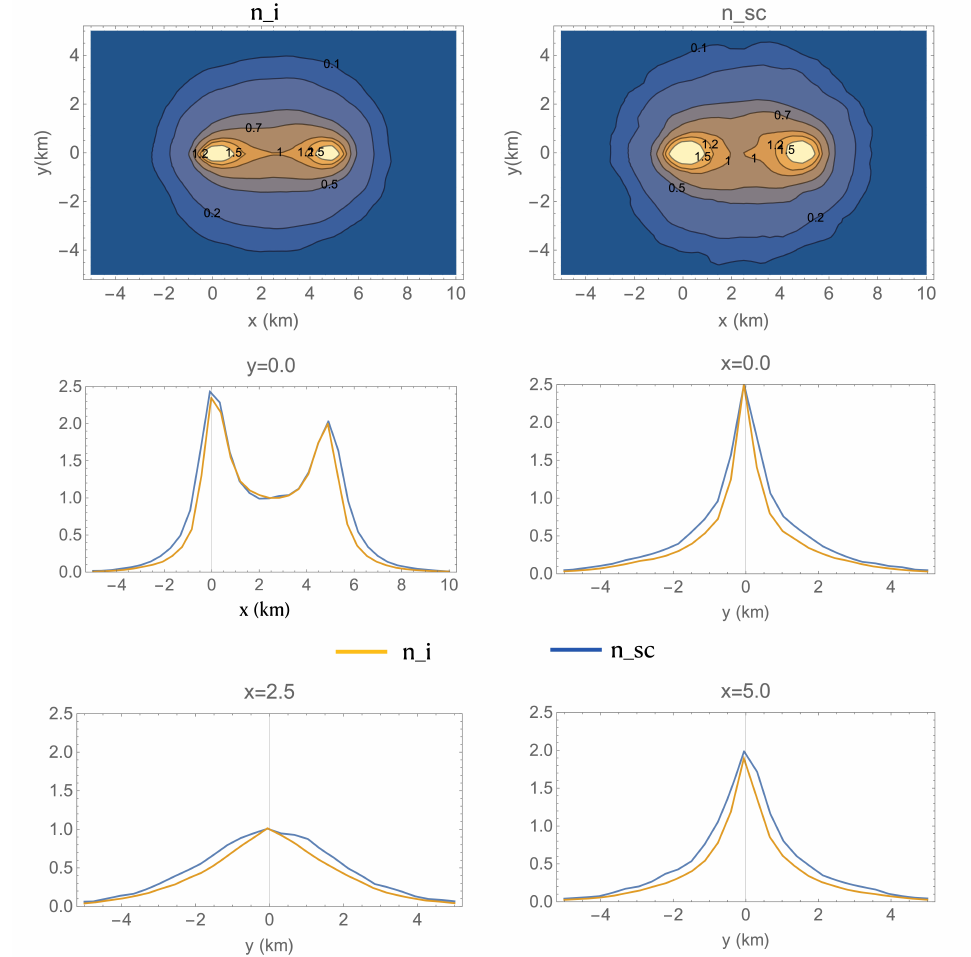
Figure 4. Redrawn from [16]. Contour plots (upper panels) of the numerically generated SWF (2D)